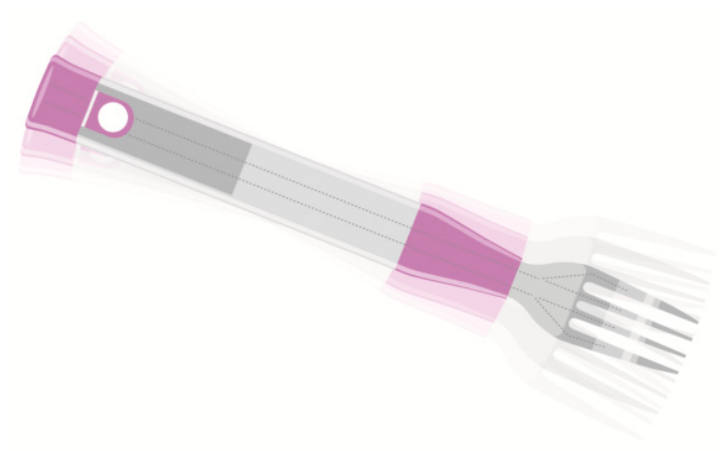
Figure 3. A smart fork that helps the user to decrease eating rate by calculating eating speed and meal duration. A red-light indication and a vibration appear when eating rate is accelerated [50].